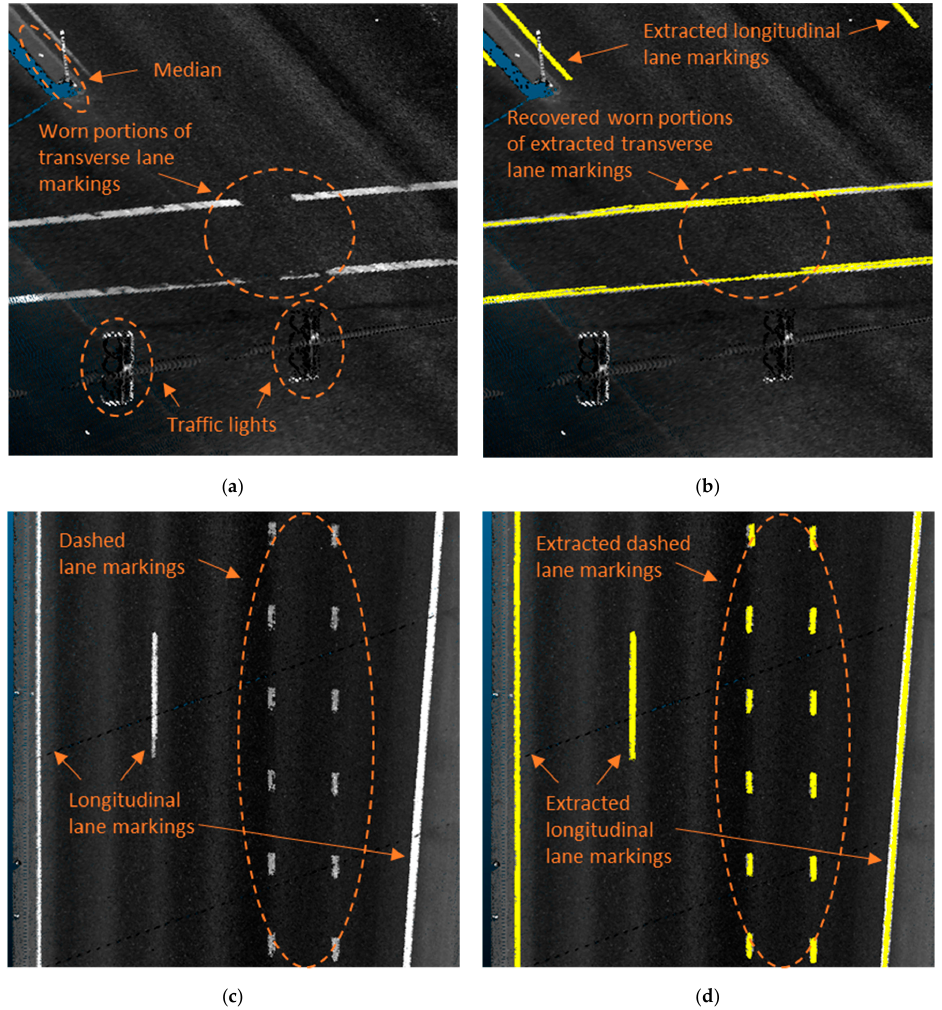
Figure 5. Example of line association: ( a ) worn lane markings (white); ( b ) extracted and associated lane markings (yellow); ( c ) dashed lane markings (white); and ( d ) extracted dashed land markings (yellow).